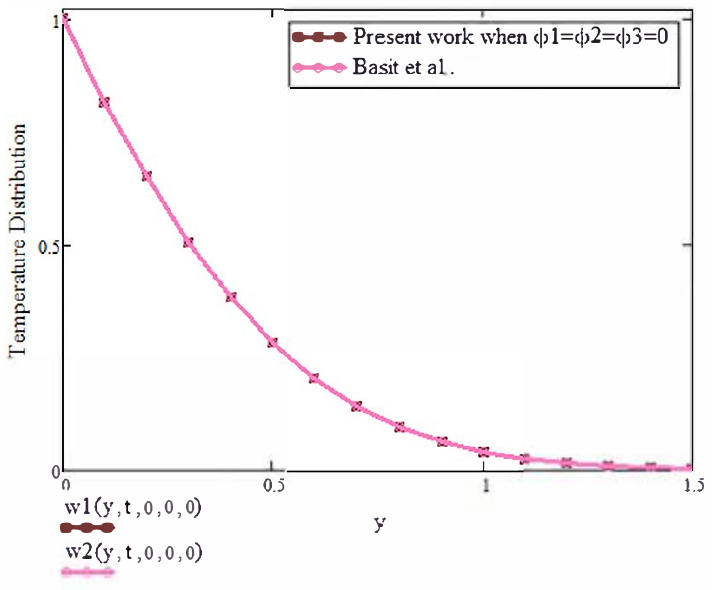
Figure 9. Comparison graph of temperature between present work and Basit et al. [2] when t = 0.8, a = 0.9, λ = 0.5, Pr = 6.2, β 1 =